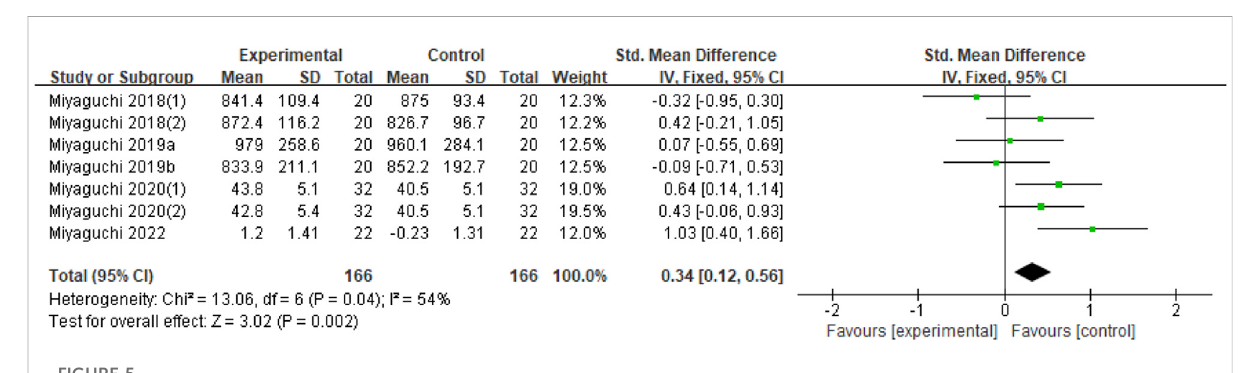
FIGURE 5 Forest plot for the effect of online stimulation on improving motor